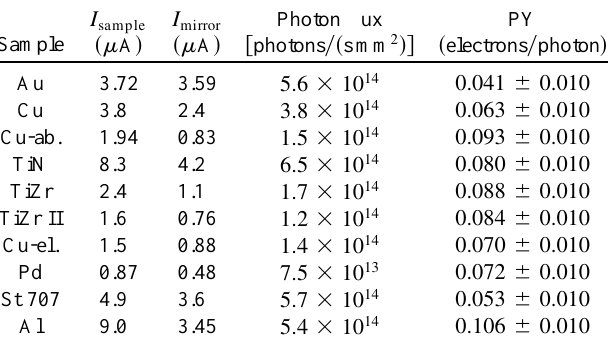
TABLE III. The PY per incident photon for the different as- received samples studied. In the second and third columns the sample drain currents and the last refocusing mirror drain currents are reported, respectively. In the fourth column the estimated photon flux is given (see Sec. II A) for details. In the last column the PY is reported with its absolute error.